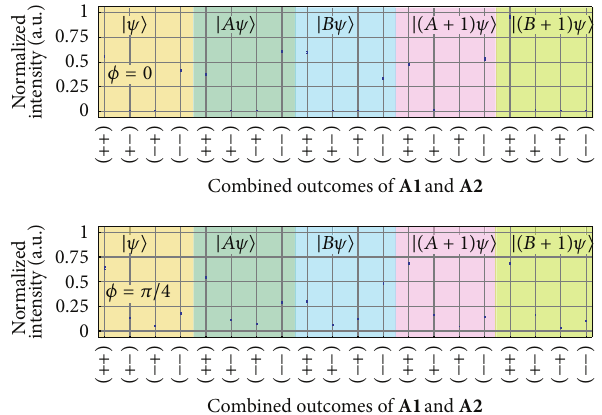
Figure 4: Normalized intensity of the successive measurements carried out by apparatuses A1 and A2 . The combined projective measurements of 𝑂 𝐴 and 𝐵 have four outcomes, denoted by ( ++ ), ( +− ), ( −+ ), and ( −− ), and have to be recorded for each initial state, that is, |𝜓⟩ , |𝐴𝜓⟩ , |𝐵𝜓⟩ , |(𝐴 + 1 )𝜓⟩ , and |(𝐵 + 1 )𝜓⟩ . Here 𝑂 𝐴 is varied within the 𝑥𝑦 -plane with azimuthal angle given by 𝜙 = 0,𝜋/4 . Error bars represent ± one standard deviation of the normalized intensities. Some error bars are at the size of the